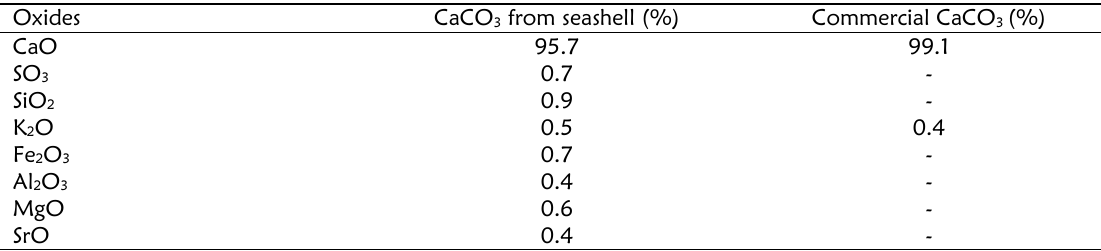
Table 2: Chemical composition of seashell and commercial CaCO 3 Source: Michele et al. (2012). Oxides CaCO 3 from seashell